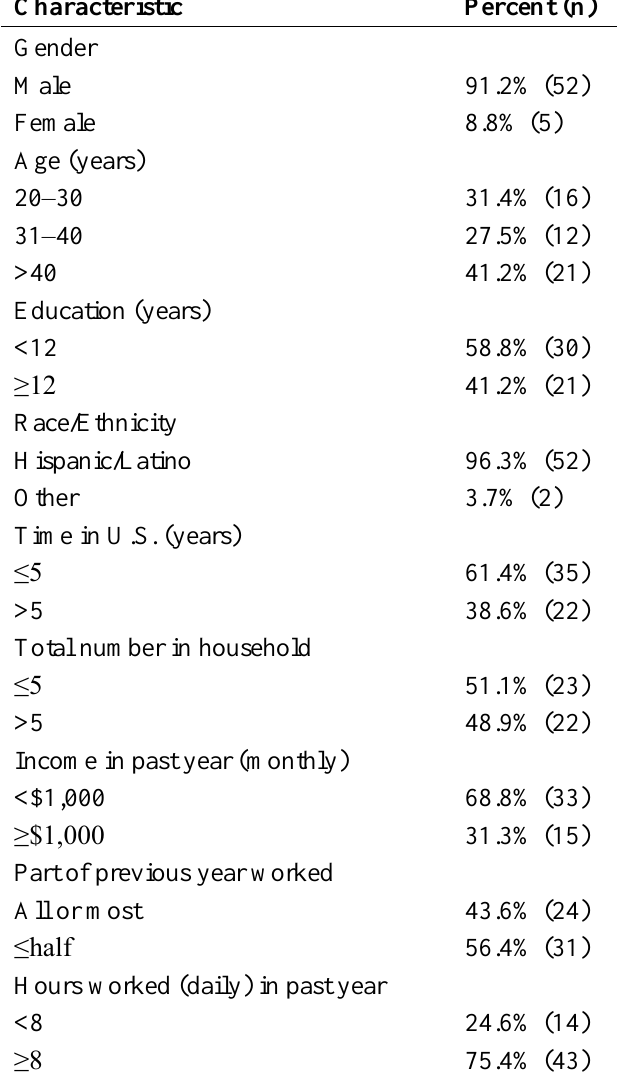
Table 1. Demographic and occupational characteristics of survey